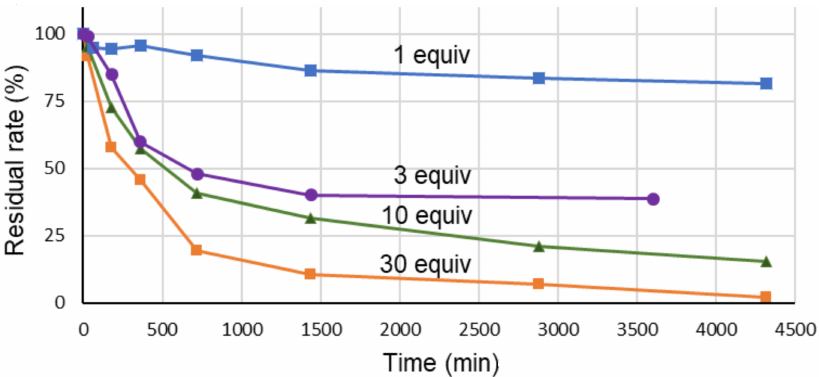
Figure 2. Temporal change of the addition reaction and the residual rate of 1 .